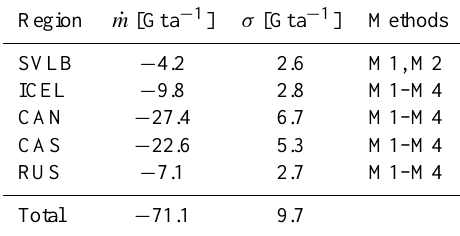
Table 4. The final regional and total geodetic mass balance ˙ m esti- mated using the results from the cross-validation procedure and in situ comparison for Iceland, with corresponding error estimates ( σ